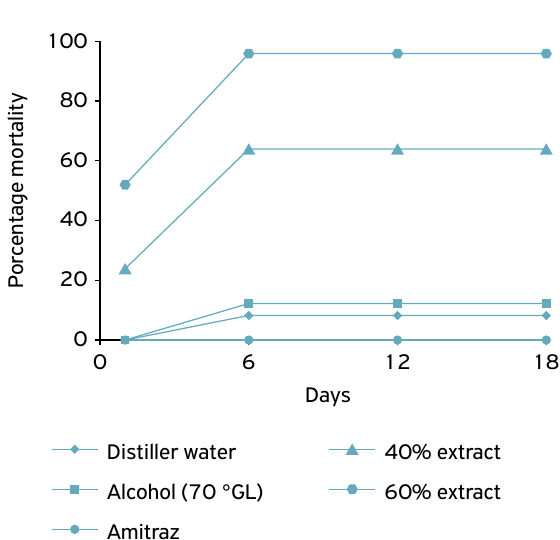
Figure 1. Mortality (%) on the 1 st , 6 th , 12 th and 18 th days among the teleogynes of Rhipicephalus (Boophilus) microplus that were treated in vitro with distilled water, alcohol (70º), amitraz and 40 and 60% extracts of C. ambrosioides and maintained under biochemical oxygen demand (BOD) conditions at a temperature of 27ºC ( ± 1) and 80% relative humidity ( ±